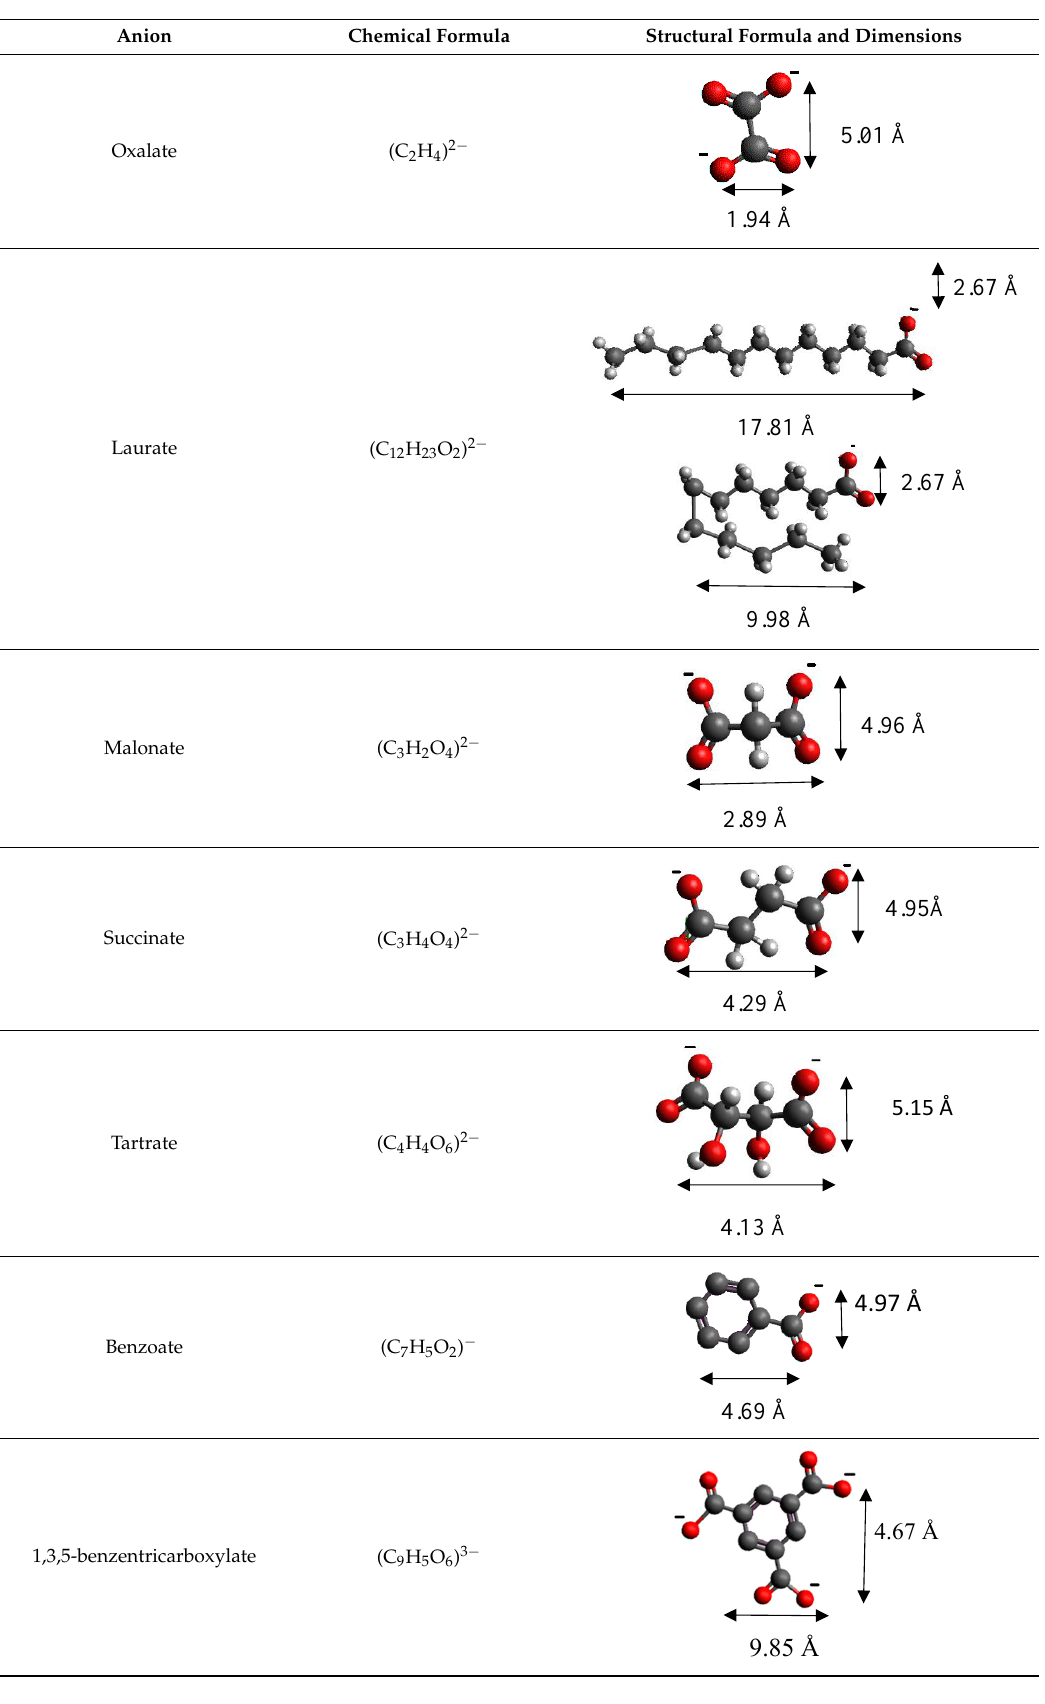
Table 2. Formula and dimensions of Table 2. Formula and dimensions of anions. Table 2. Formula and dimensions of anions. Table 2. Formula and dimensions of anions. Table 2. Formula and dimensions of anions. Table 2. Formula and dimensions of anions.